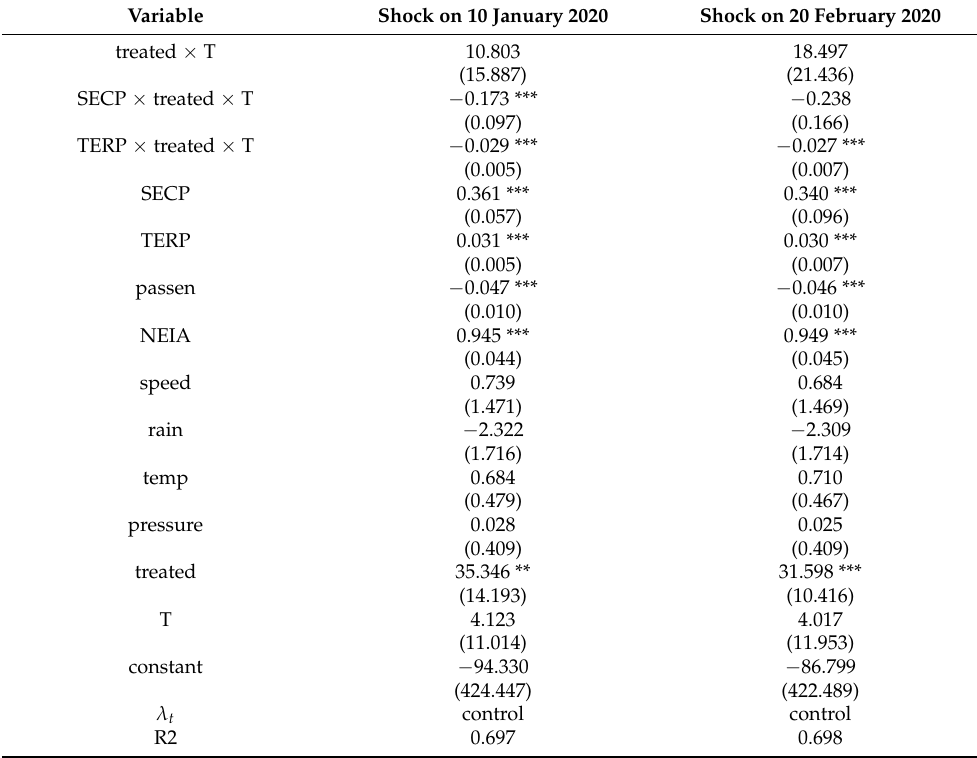
Table 7. Placebo test results.